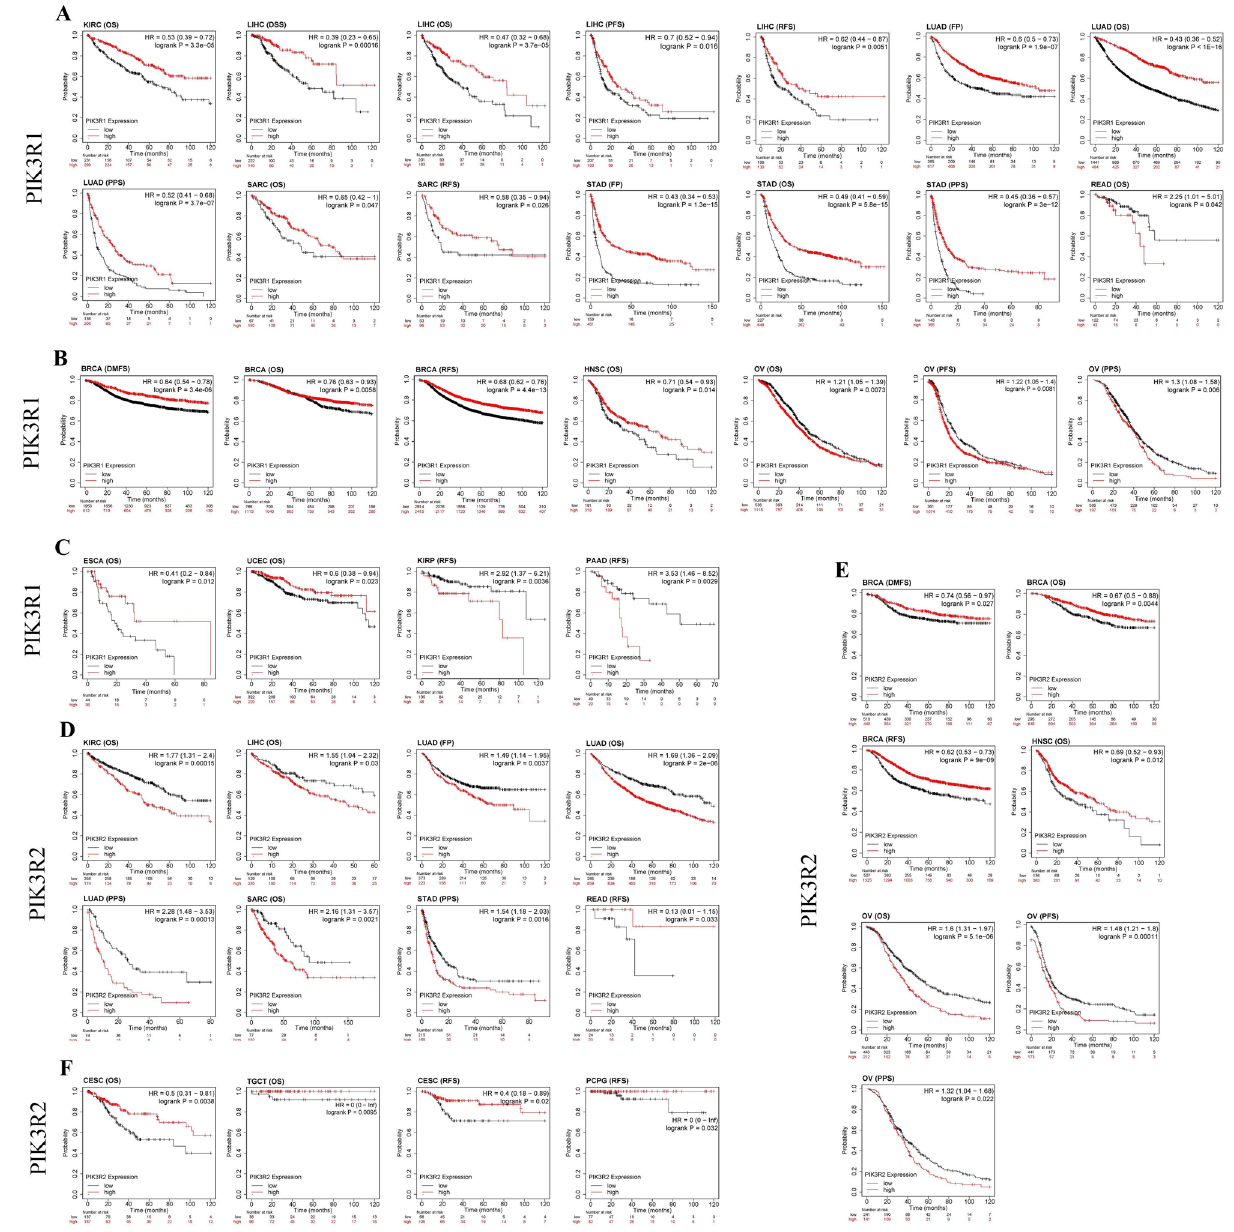
Figure 2. Survival curves comparing low and high expressions of PIK3R1 and PIK3R2 in different tumors. ( A ) Correlations between PIK3R1 expression levels and patient survival in KIRC, LIHC, LUAD, SARC, STAD, READ were analyzed using Kaplan–Meier Plotter database (https:// kmplot. com/ analy sis). ( B ) Correlations between PIK3R1 expression levels and patient survival in BRCA, HNSC, OV. ( C ) Correlations between PIK3R1 expression levels and patient survival in ESCA, UCEC, KIRP, PAAD. ( D ) Correlations between PIK3R2 expression levels and patient survival in KIRC, LIHC, LUAD, SARC, STAD, READ. ( E ) Correlations between PIK3R2 expression levels and patient survival in BRCA, HNSC, OV. ( F ) Correlations between PIK3R2 expression levels and patient survival in CESC, TGCT, PCPG. All the survival analyses were conducted via Kaplan–Meier Plotter database (https:// kmplot. com/ analy